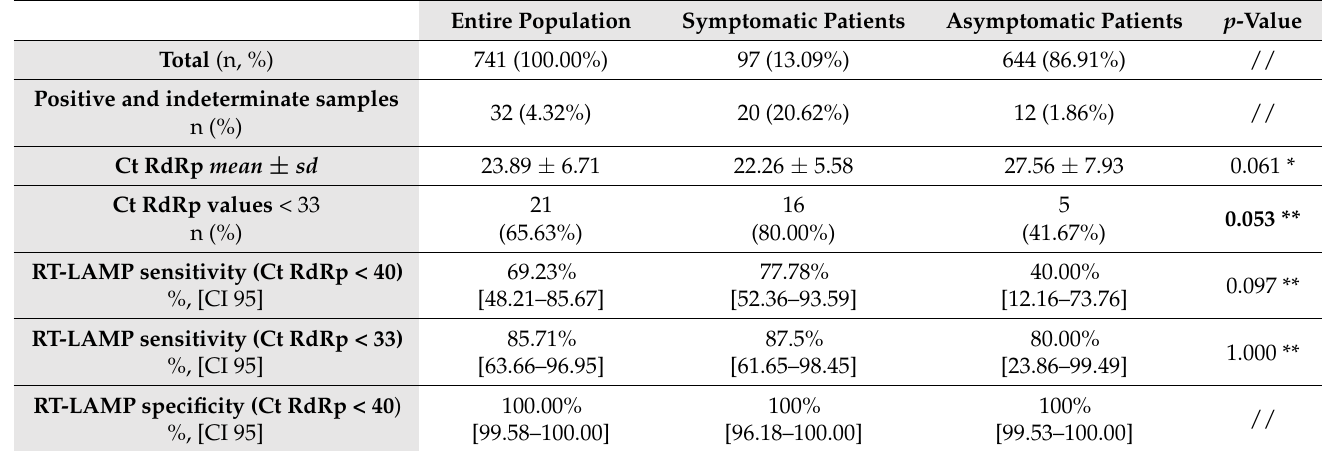
Table 2. RdRp Ct values and diagnostic accuracy of RT-LAMP considering different patient groups. Entire Population Symptomatic Patients Asymptomatic Patients p